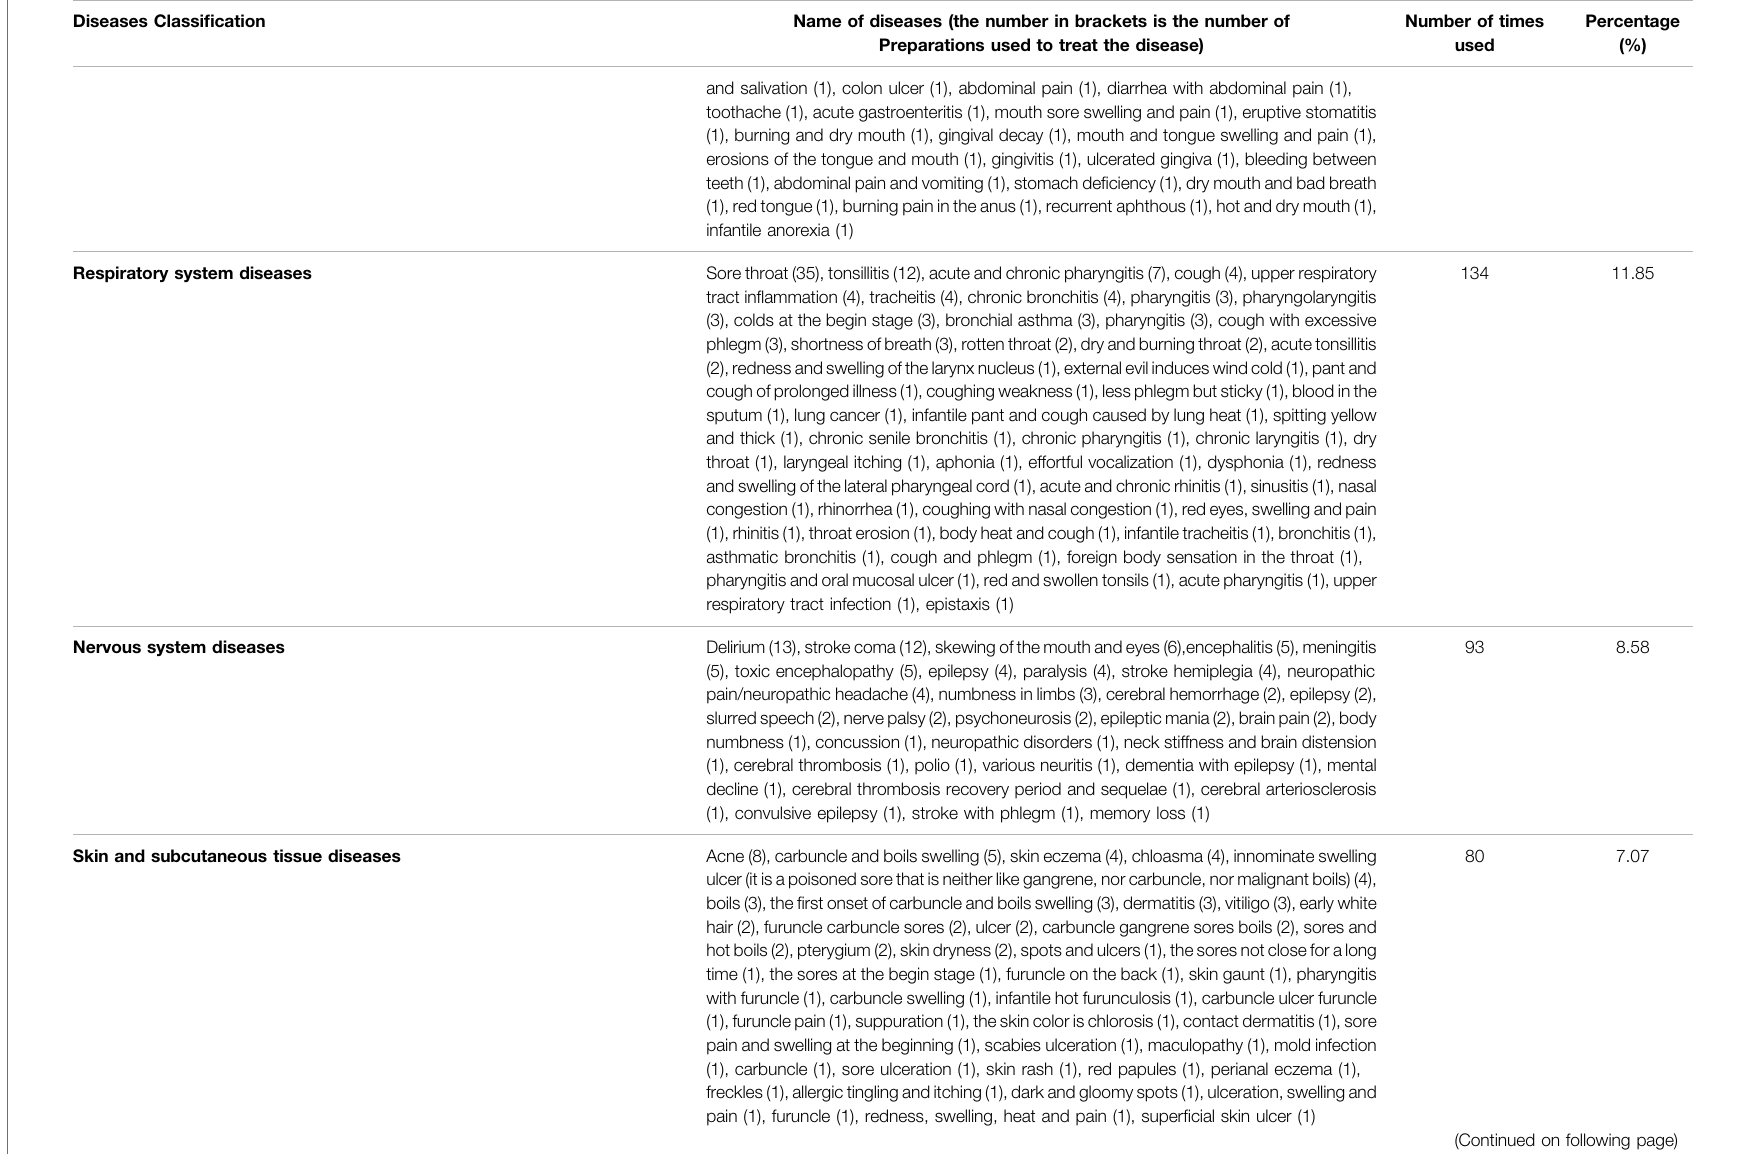
TABLE 4 | ( Continued ) Classi fi cation statistics table for the indications of preparations containing